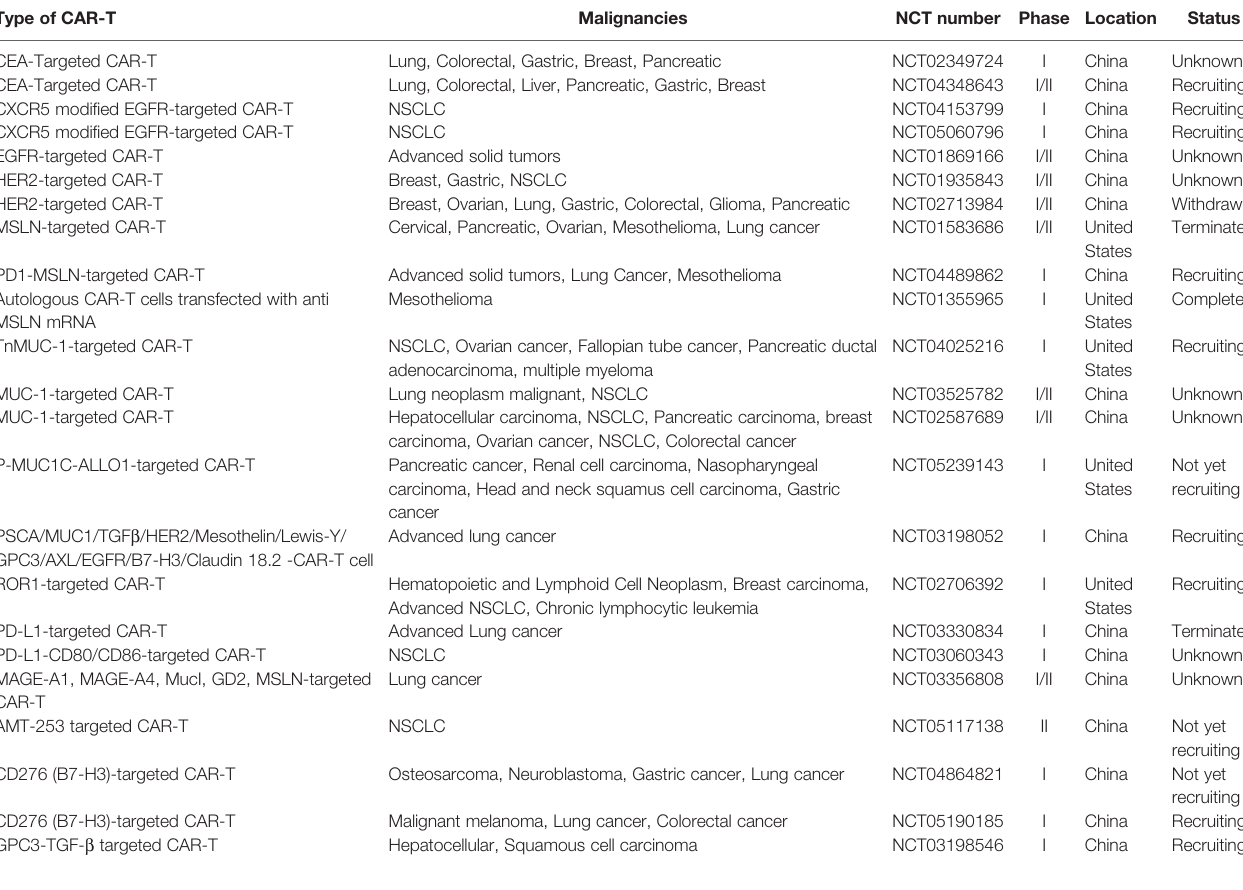
TABLE 1 | Potential TAAs in CAR-T cell therapy clinical tails for lung cancer (ClinicalTrials.gov).